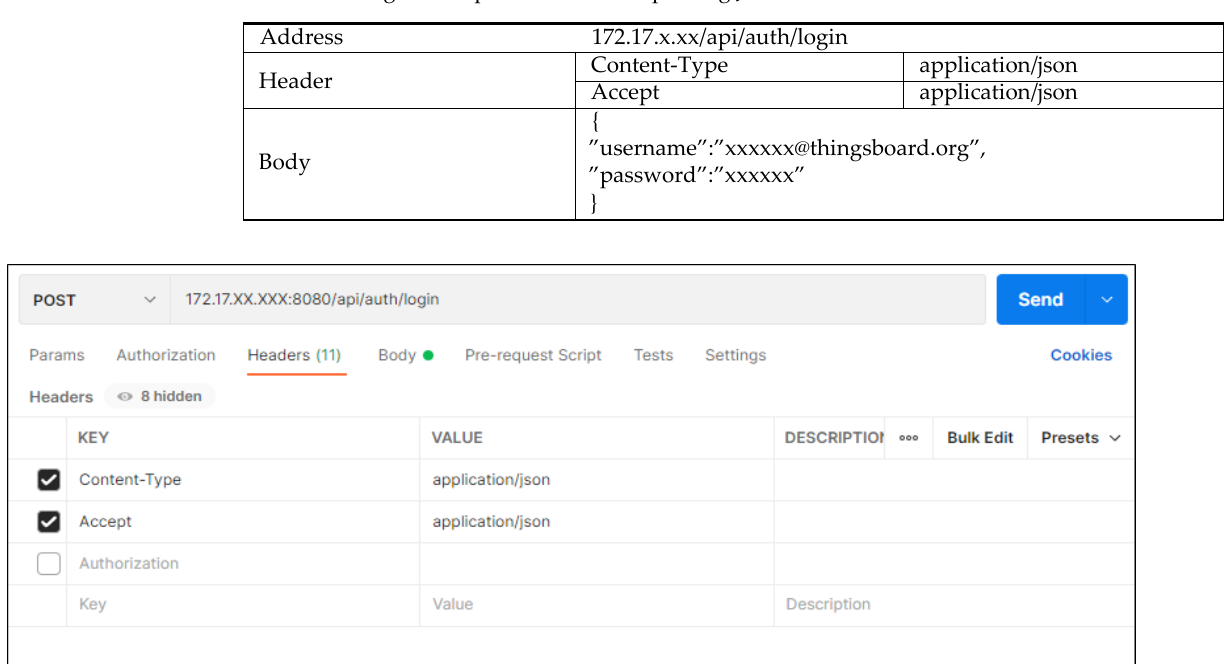
Table 4. Configuration parameters for requesting JWT token.